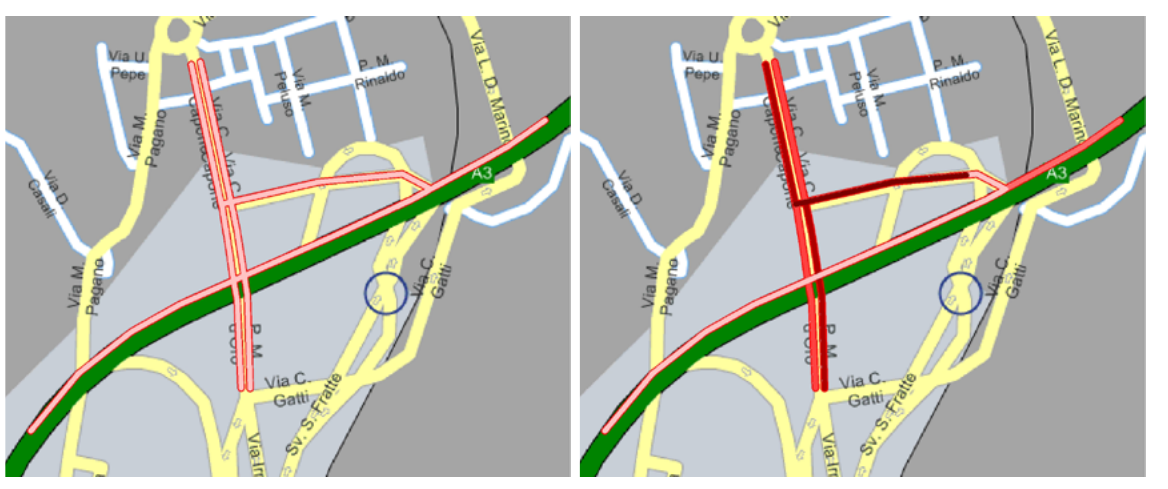
Figure 6. A focus on a relevant junction: Salerno Fratte before (left) and after (right) the